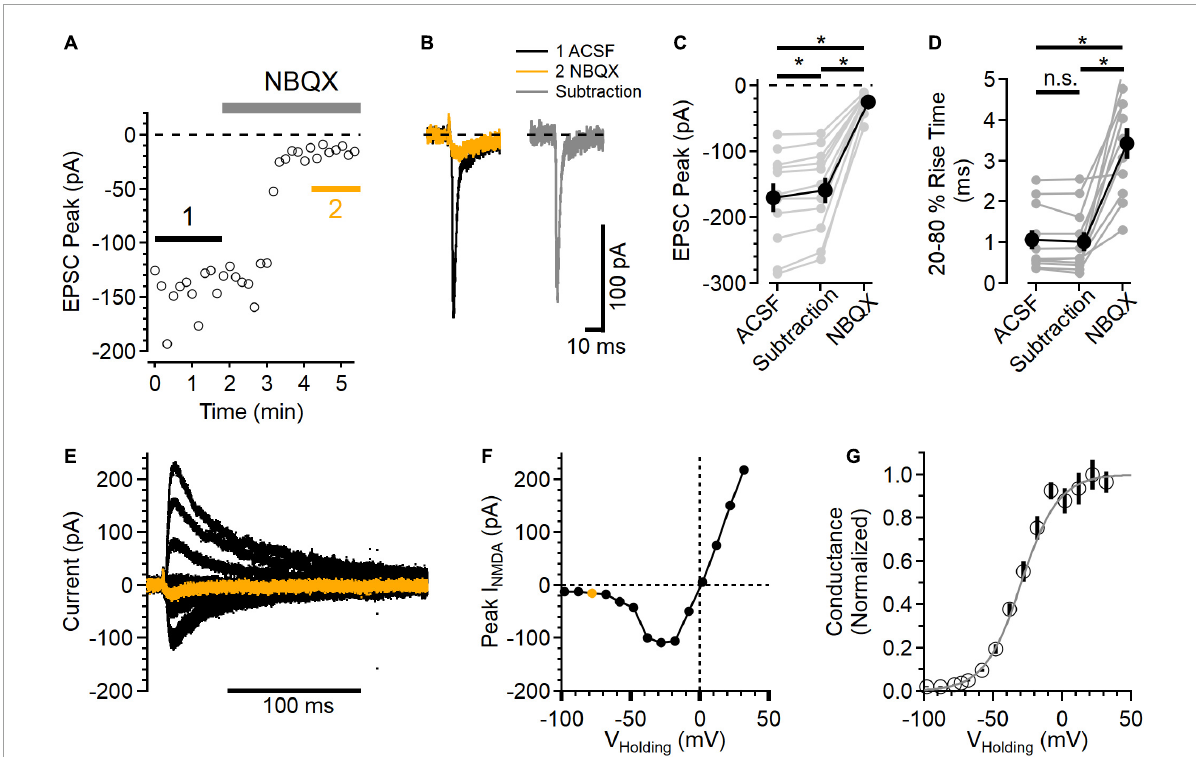
FIGURE2 Postsynaptic NMDAR currents in layer 2/3 neurons. (A) Time course of NBQX (10 µ M) inhibition of peak EPSC current measured in voltage clamp, V Holding = –78 mV. (B) Average EPSCs from the regions indicated in (A) . The black trace is the control EPSC (ACSF), the orange trace is after NBQX addition, and the gray trace is the subtraction of the NBQX trace from the ACSF trace. (C) Peak NBQX-sensitive current isolated by subtraction is smaller than the peak ACSF control trace, and the current remaining in NBQX was significantly smaller than either the ACSF or subtracted condition [Friedman test statistic = 22.0 (6.0), p = 1.7E-5, ACSF vs. subtracted current p = 9.8E-4, ACSF vs. NBQX p = 9.8E-4,